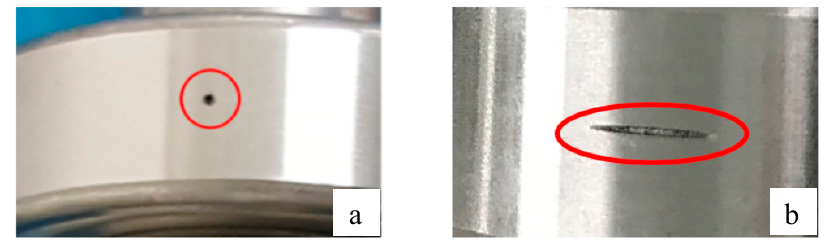
Figure 3. Faulty bearings ( a ) hole; and ( b ) scratch.